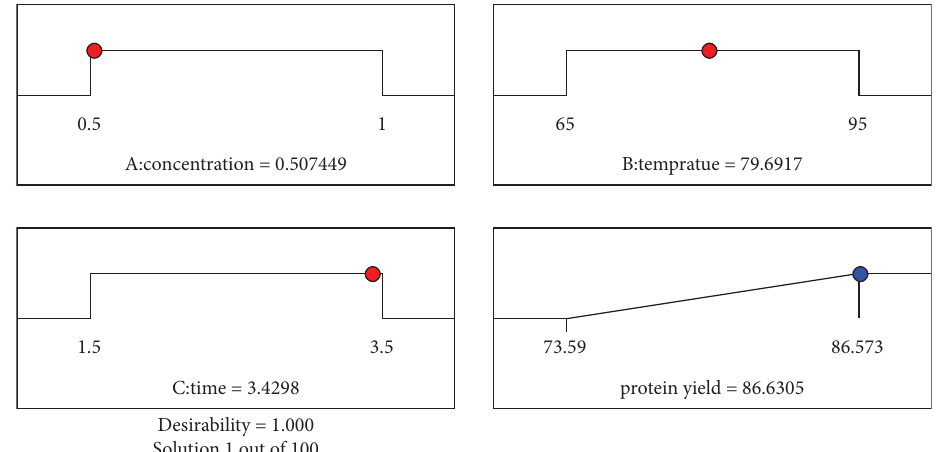
Figure 13: Ramp plot of optimization solution for the